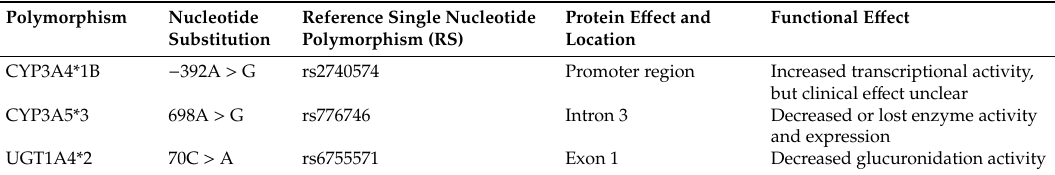
Table 1. Location and e ff ects of CYP3A4*1B, CYP3A5*3 and UGT1A4*2